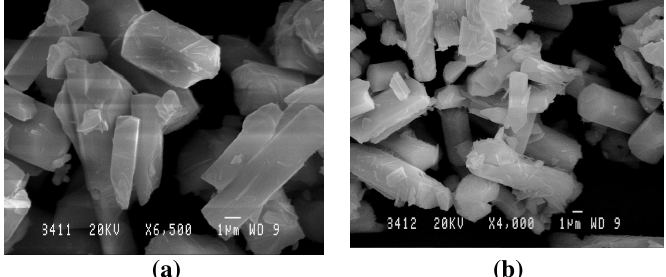
Figure 6. Scanning electron micrographs of gallosilicate nitrate